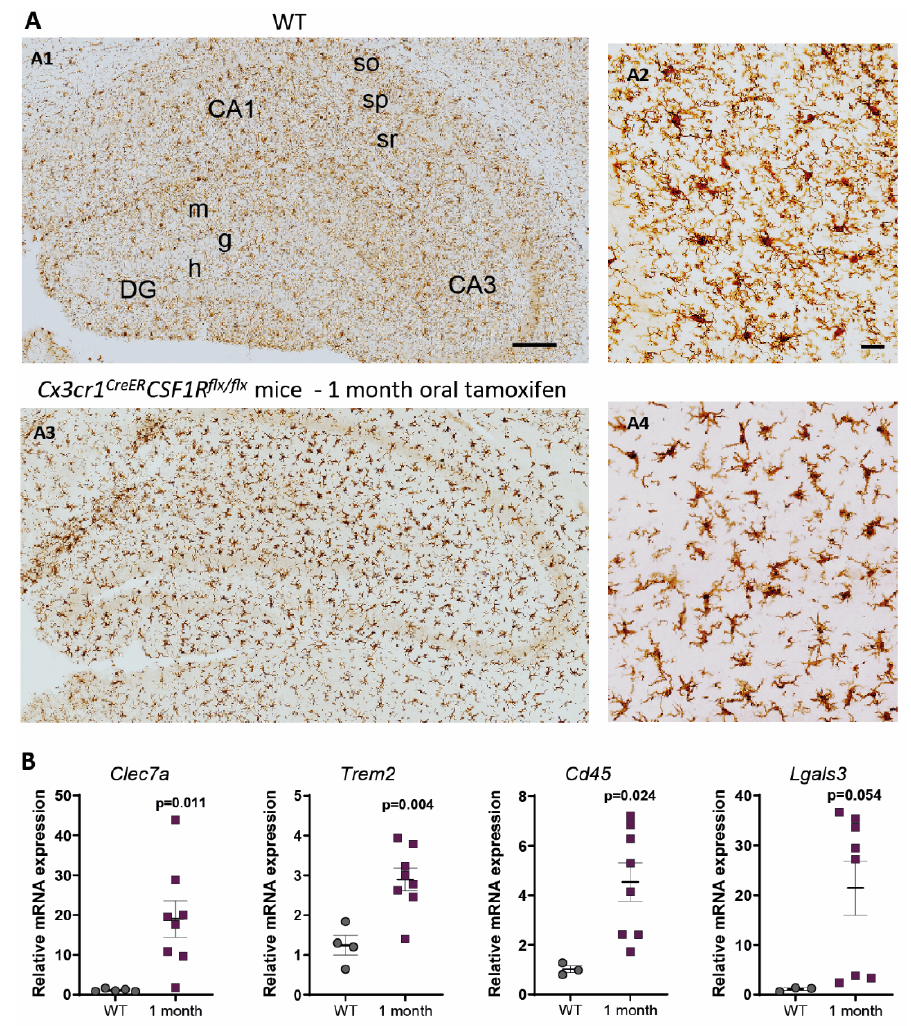
Figure 3. Microglial activation after 1-month oral tamoxifen administration in Cx3cr1 CreER /Csf1r flx/flx mice. ( A ). Iba1 immunostaining in WT and Cx3cr1 CreER /Csf1r flx/flx mice subjected to 1-month of tamox- ifen treatment. CA1, field CA1 of hippocampus; CA3, field CA3 of hippocampus; DG, dentate gyrus; so, stratum oriens; sp, stratum pyramidale; sr, stratum radiatum; m, molecular layer; g, granular